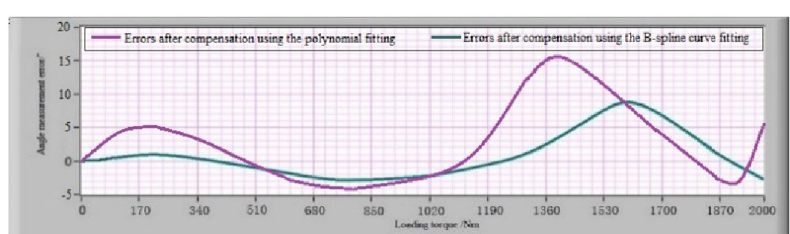
Figure 15. Errors of MSOS after compensation using the polynomial fitting and the B-spline curve fitting